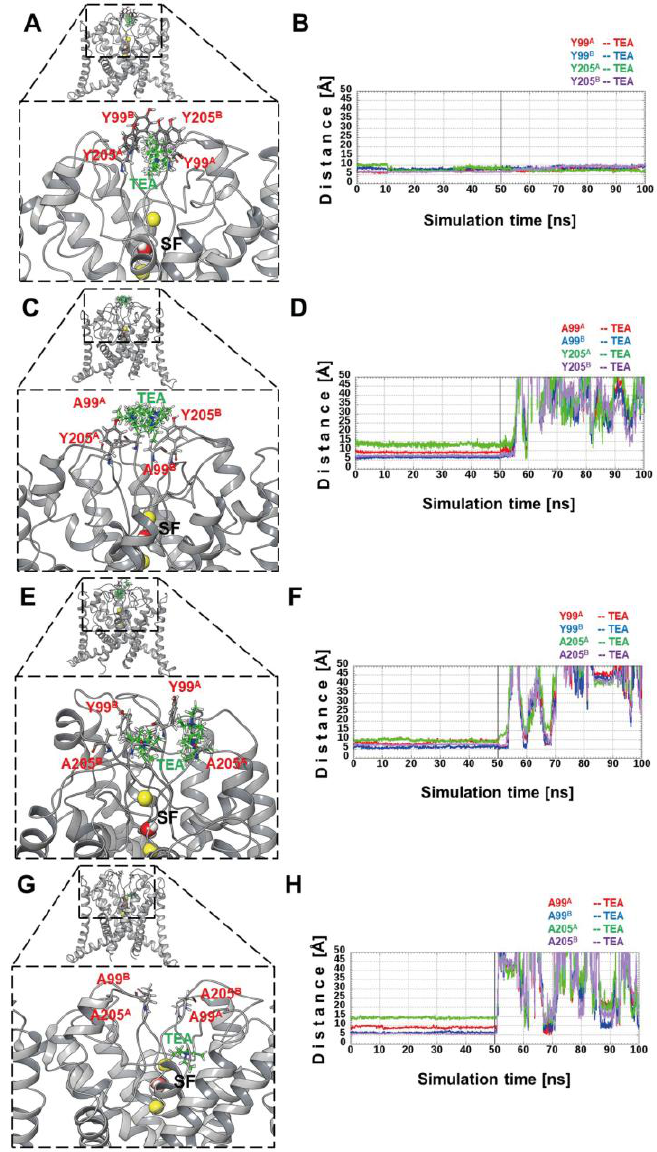
Figure 6. Docking clusters and TEA-Tyr (Tetraethylammonium-Tyrosine) (99 and 205) distances: ( A , C , E , G ) cluster of TEA poses (in green color) obtained by docking analysis for 2loop2, 2loop2/A99, 2loop2/A205 and 2loop2/A99/A205 channels, respectively. In red are shown the residues forming the binding site of TEA near to the selectivity filter (SF). In yellow color, K + ions are depicted and water molecules are represented in red and white, placed in the SF. The superscript letter implies the monomer to which it belongs. ( B ) shows the distances between the 1st best poses and the tyrosine residues, respectively. Similarly, the distances between the 1st best poses and the tyrosine residues 2loop2/A99, 2loop2/A205 and 2loop2/A99/A205 mutant channels are shown in ( D , F , H ),